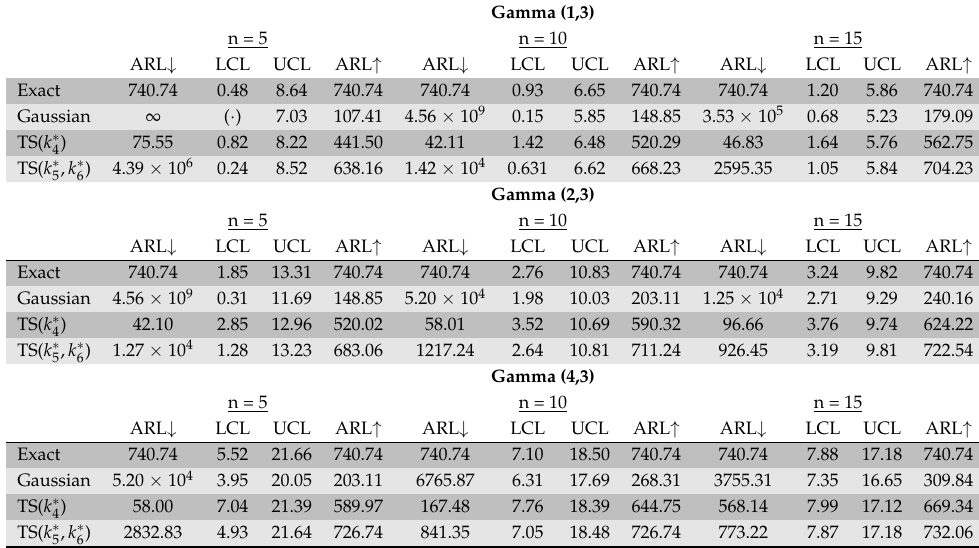
Table 1. Upper and lower control limits and in-control average run lengths for an ¯ X -chart on a ) distributed process with subgroups of size n and desired type-1 error of α = 0.0027. Gamma ( γ , 1 λ Gamma (1,3) n =